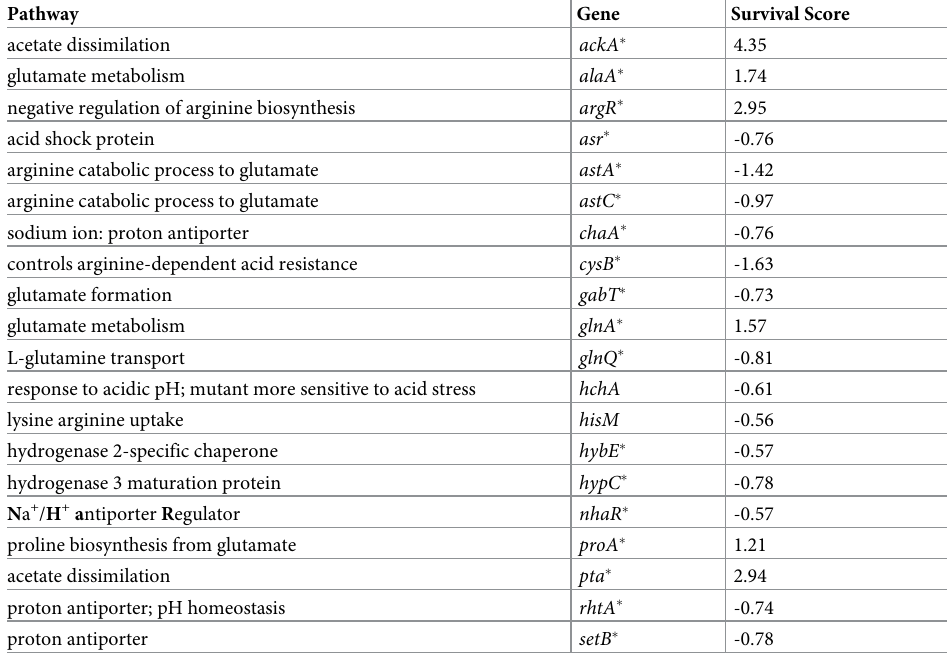
Table 2. Genes from survival profiling candidate lists that fall in the newly identified pathway of pH homeostasis.